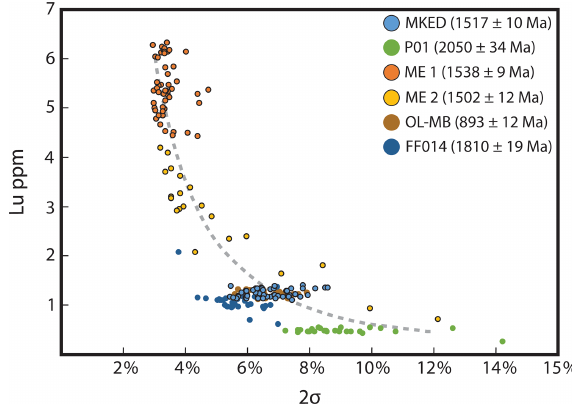
Figure 4. Lu parts per million vs. 2 σ uncertainty for each calcite analysis. The grey curve shows a function fitted to the data from samples with ages between 1500 and 1540Ma (samples ME 1, ME 2, and MKED, with symbols outlined in black). Only data points with similar ages were used to construct this guiding curve as the obtained precision is age-dependent. The Lu–Hf ages for older samples (e.g. P01 and FF014) are more precise relative to younger samples for a given Lu concentration (assuming no common Hf). Note: MKED is the calcite Lu–Hf standard used to correct the anal- ysed samples. All data for MKED are included in Simpson